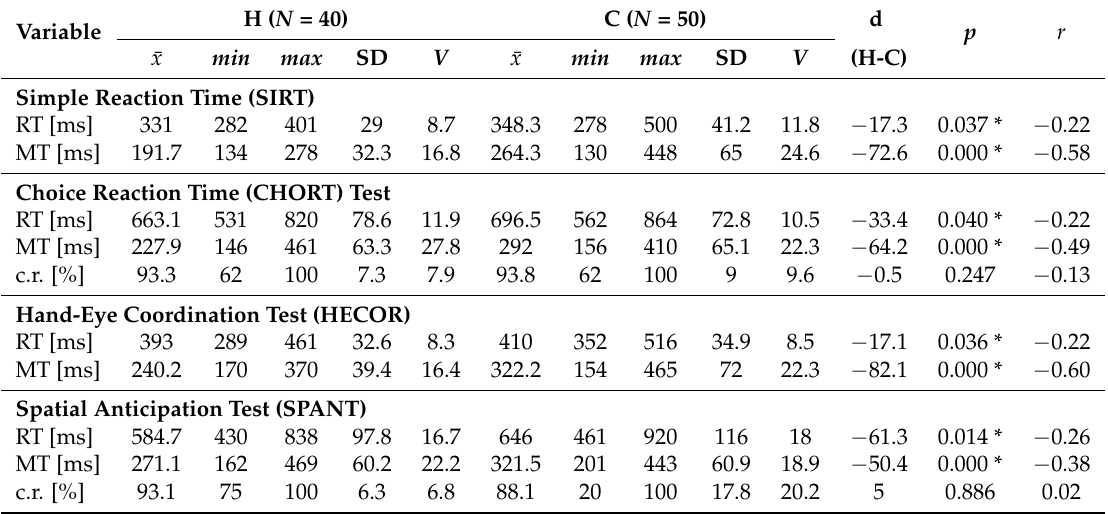
Table 3. Numeral characteristics of psychomotor abilities of handball players vs control group.